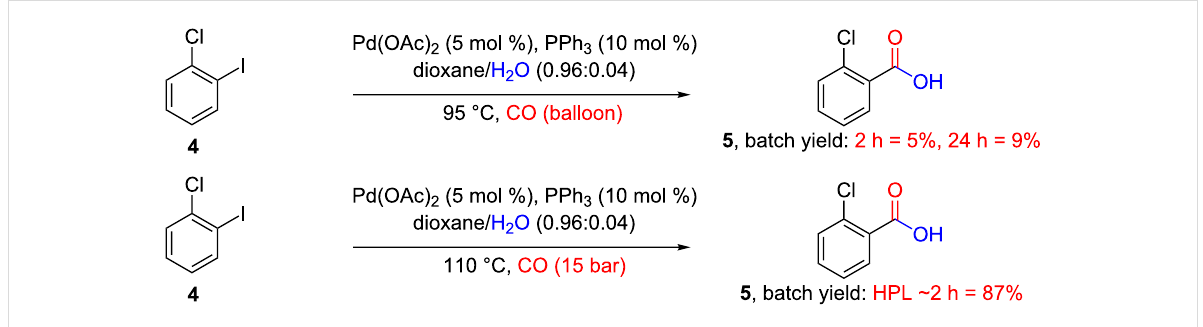
Scheme 3: The batch carbonylation of 2-chloro-1-iodobenzene in conventional lab (top) and using a Parr autoclave in high pressure lab (bottom).